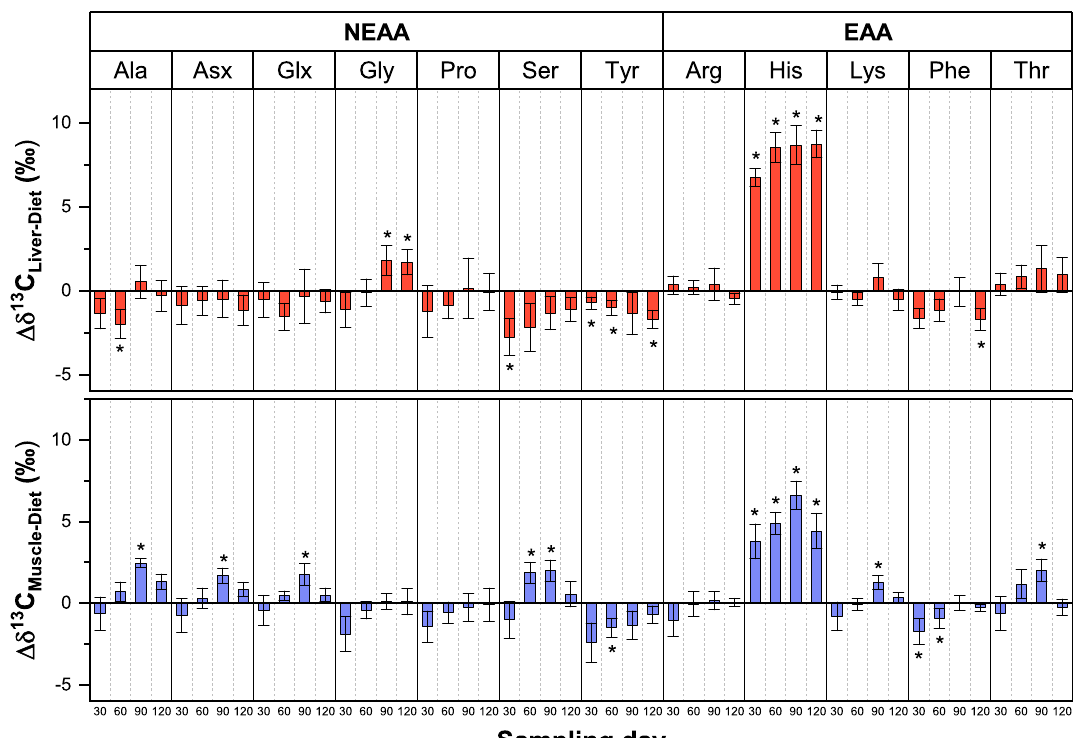
Figure 1. Carbon stable isotope signatures of AAs show low trophic fractionation between fish liver/muscle and dietary samples except for His. Trophic fractionation between stickleback and dietary samples was estimated by calculating Δδ 13 C values ± SD (error bars, n = 5) for liver ( ) and muscle ( ) samples. Asterisks over Δδ 13 C values indicate significant differences from two-sided t-tests against 0 ( p < 0.01, Table S3). Δδ 13 C values are generally below ± 2‰ for all AAs in muscle and liver samples except for His. The frequently significant Δδ 13 C values in muscle samples on day 90 are caused by the low protein turnover and therefore minor decrease of δ 13 C values in muscle samples compared to the significant δ 13 C decrease in dietary samples. Arg and Lys have the lowest trophic fractionation